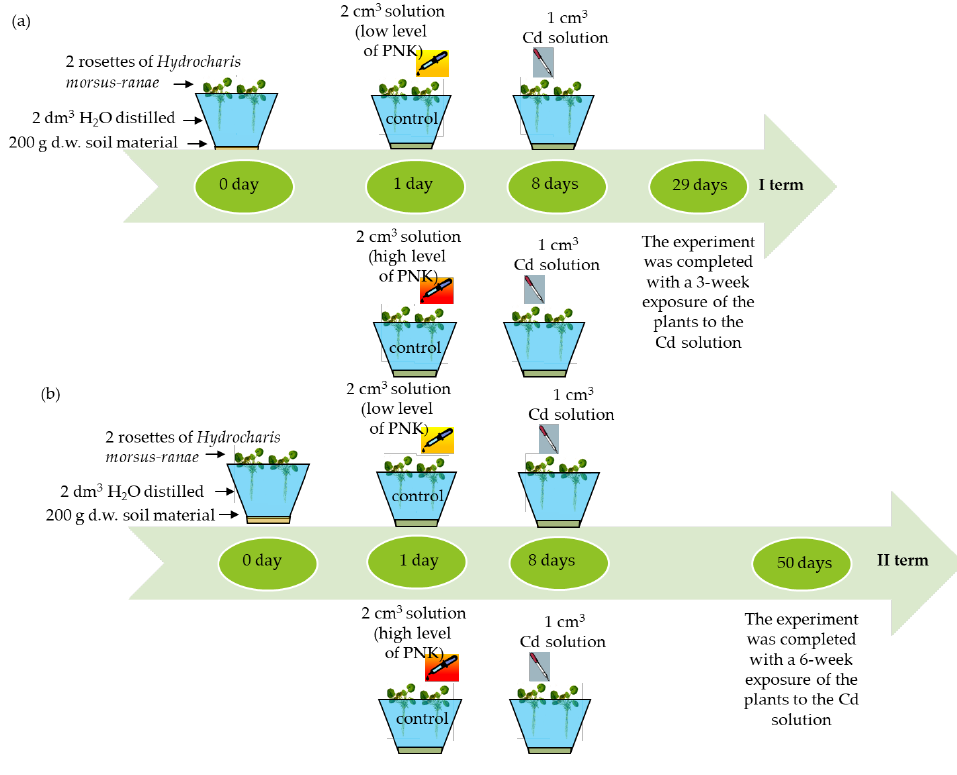
Figure 1. Scheme of the experiment with a European frogbit ( a ) a 3-week exposure of the plants to the Cd solution (I term); ( b ) a 6-week exposure of the plants to the Cd solution (II term); four replications in each from three growing seasons, Σ12 replications.